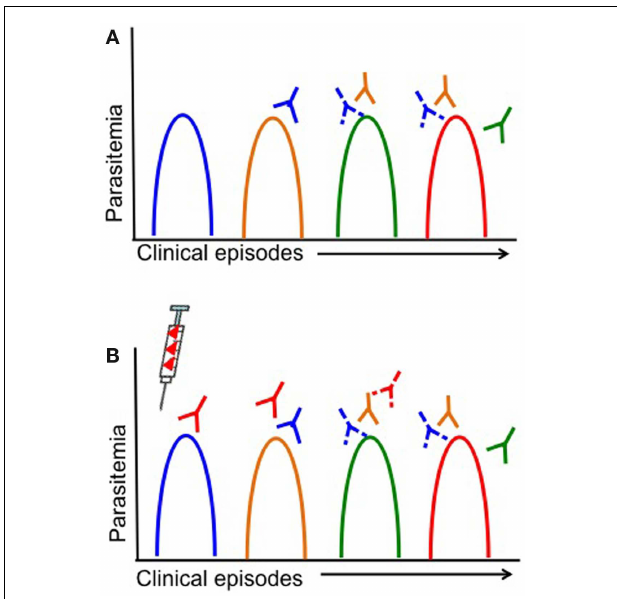
FIGURE 3 |Antigenic diversity, clinical malaria, and vaccine efficacy are shown . Simplified overview of the impact of parasite antigenic diversity on the dynamics of natural infection and the efficacy of vaccines. Peaks in parasitemia correspond with different clinical episodes and colors indicate different serotypes. Strain-specific acquired antibodies are shown in corresponding colors some time after each clinical episode. Solid lines represent a strong antibody response, while dashed lines represent limited antibody responses. (A) Dynamics of natural infection with recurrent episodes of clinical malaria in an individual that acquires only strain-specific antibodies after being infected. As individuals experience different strains through natural infection (or vaccination), they acquire strain-specific antibodies and have a lower risk of having a clinical episode due to the same strain. (B) Lack of vaccine efficacy in a vaccinated individual due to antigenic diversity.The syringe indicates vaccination with a single serotype (red). If a single-strain vaccine is given at baseline, individuals are more likely to experience clinical episodes due to other strains (blue, yellow, green) than the vaccine strain, until antibody responses